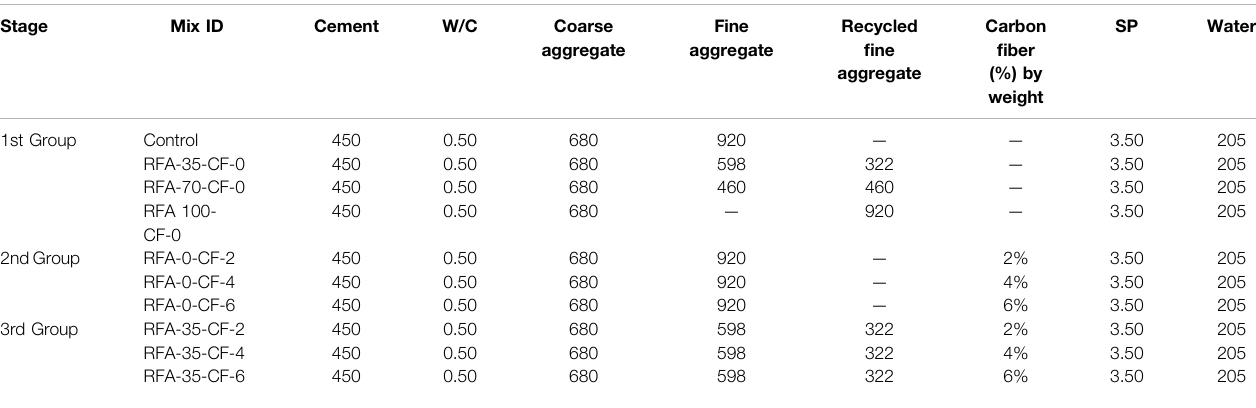
TABLE 2 | Mix proportion of concrete samples (kg/m 3